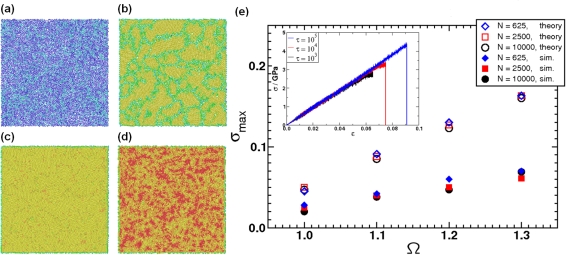
Sample configurations of systems with N = 10000 particles and different particle densities Ω. The color code displays the coordination numbers: blue (0), green (4), yellow (6), red (8). (a) Ω = 0.7. (b) Ω = 0.9 (c) Ω = 1.3 (d) Ω = 1.7 (e) Breaking strength σb for different system sizes N (filled symbols) as a function of particle density Ω, compared with the theoretical breaking strength σmax (open symbols). The inset shows the stress-strain (σ – ε) relation for systems with three different initial expansion times τ. In essence, the larger the expansion time for the generation of the random initial overlap of particles, the larger is the material strength σmax.